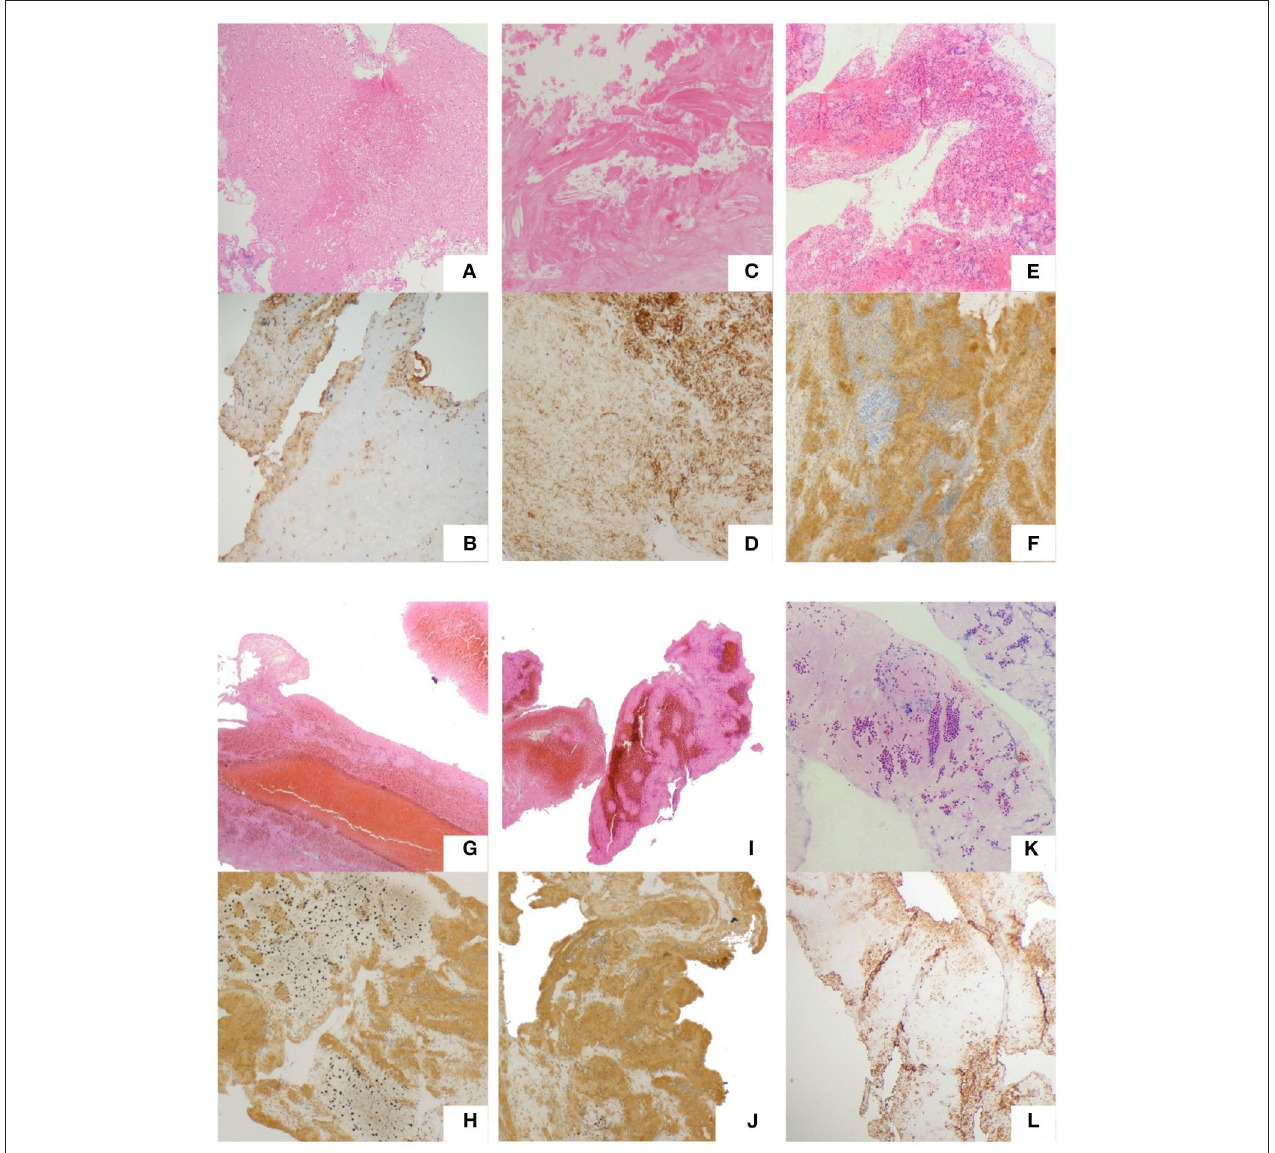
FIGURE 1 | Typical thrombi and plaques. Atrial thrombi of VHD patients. (A,B) Carotid atherosclerotic plaques of CEA patients. (C,D) Thrombi of CE. (E,F) LAA. (G,H) SOE. (I,J) SUE. (K,L) Hematoxylin and eosin staining. (A,C,E,G,I,K) Red color represents red blood cells; pink regions represent fibrin; and blue dots represent WBCs; CD31 immunostaining. (B,D,F,H,J,L) Dark brown represents platelets (magnification, 200 ⋄ ).